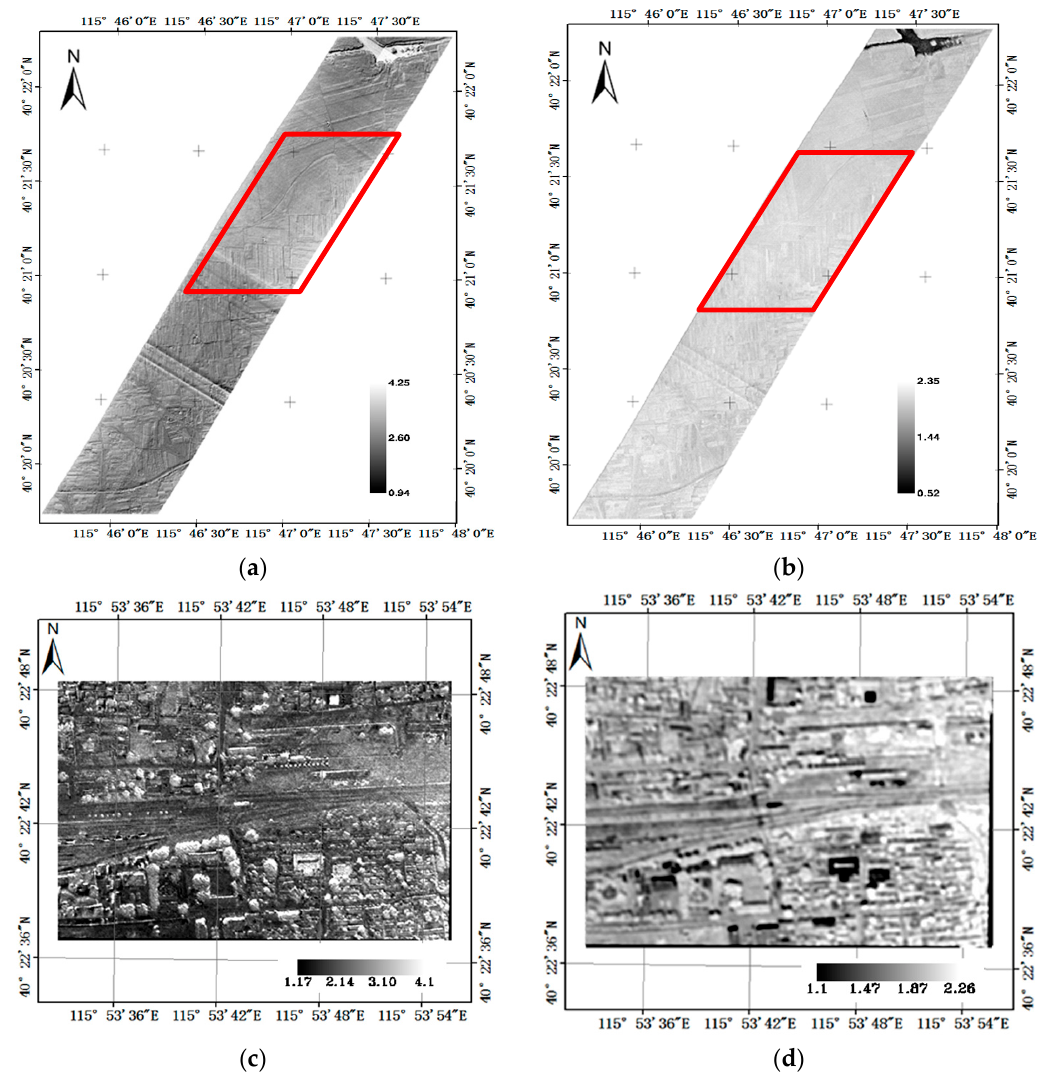
Figure 8. The estimated CWVs using Continuum Interpolated Band Ratio (CIBR) and SODA methods: